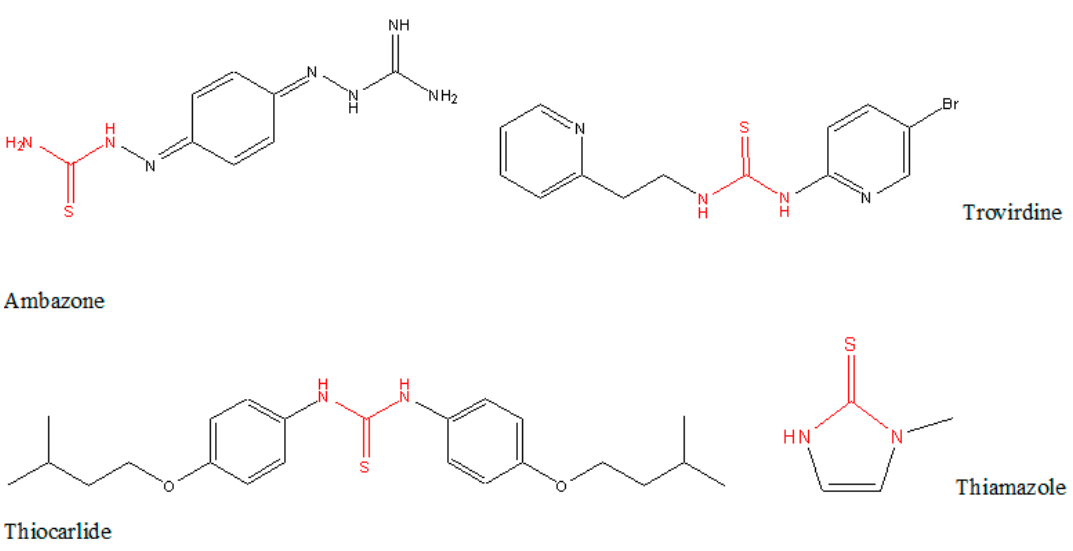
Figure 1. Structure of antiseptic Ambazone, HIV-1 RT inhibitor Trovirdine, antimycobacterial Thiocarlide, used to treat hyperthyroidism Thiamazole.